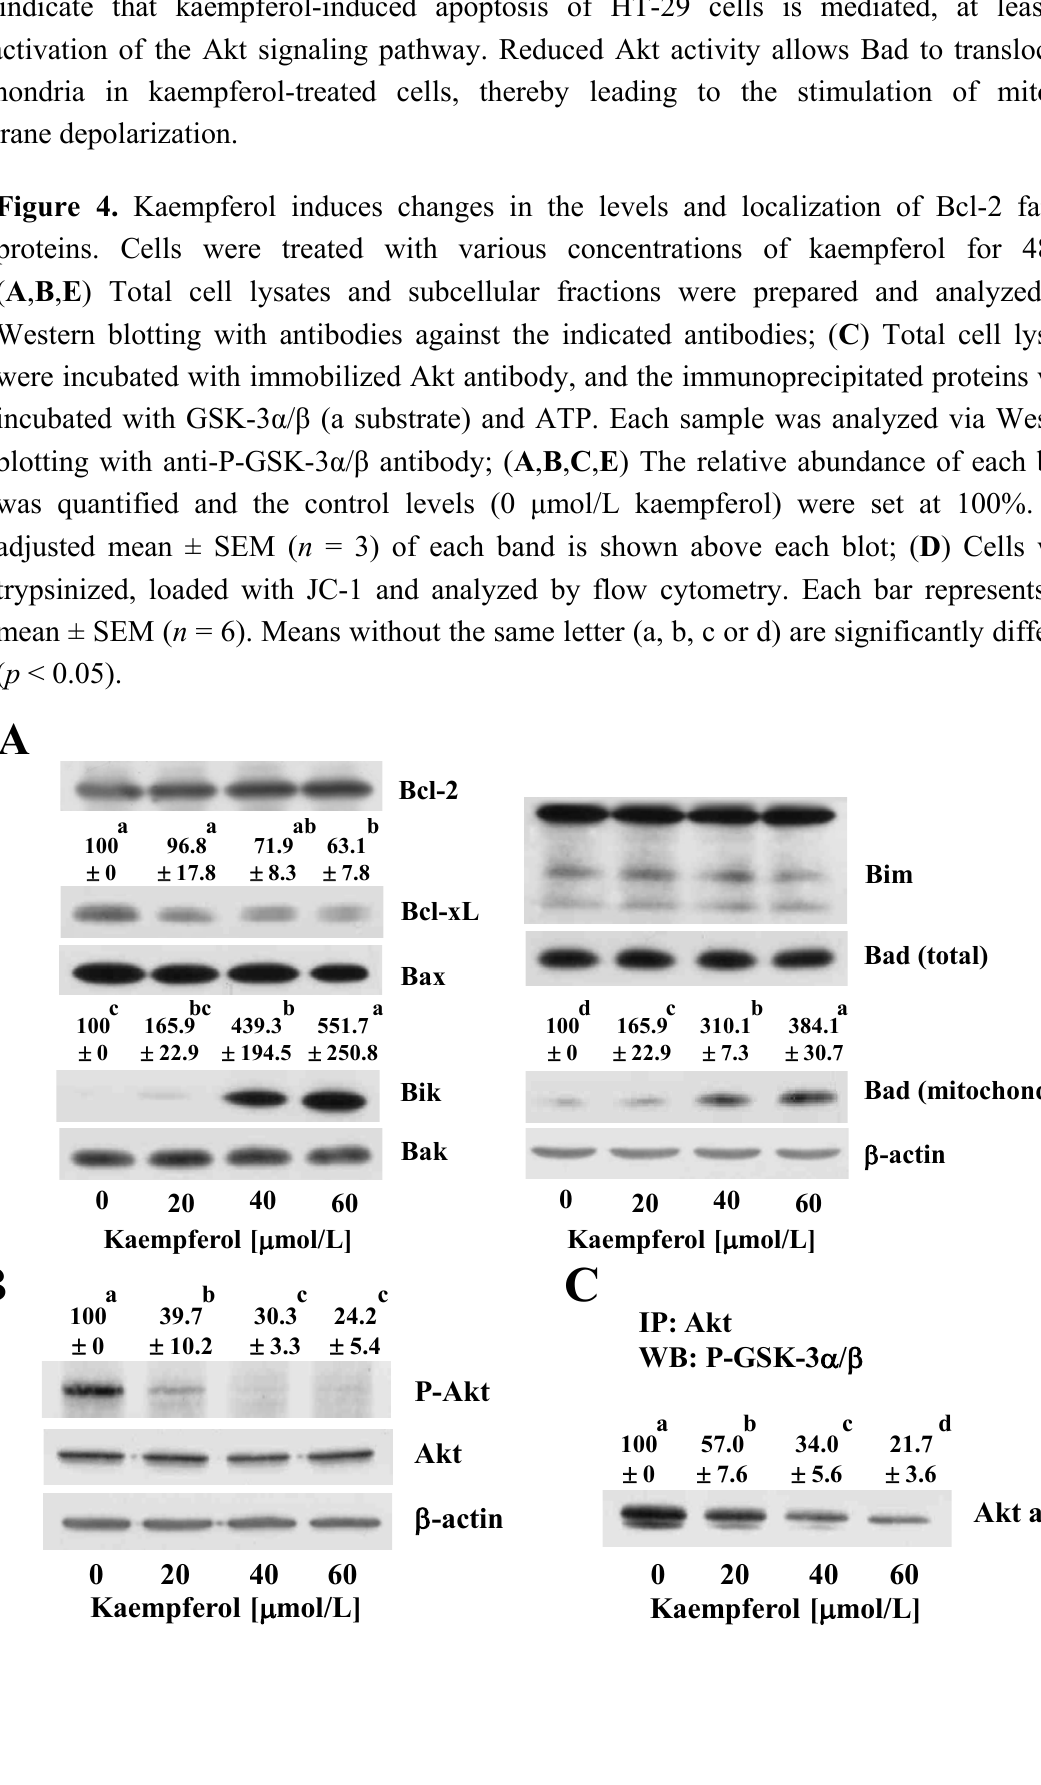
Figure 4. Kaempferol induces changes in the levels and localization of Bcl-2 family proteins. Cells were treated with various concentrations of kaempferol for 48